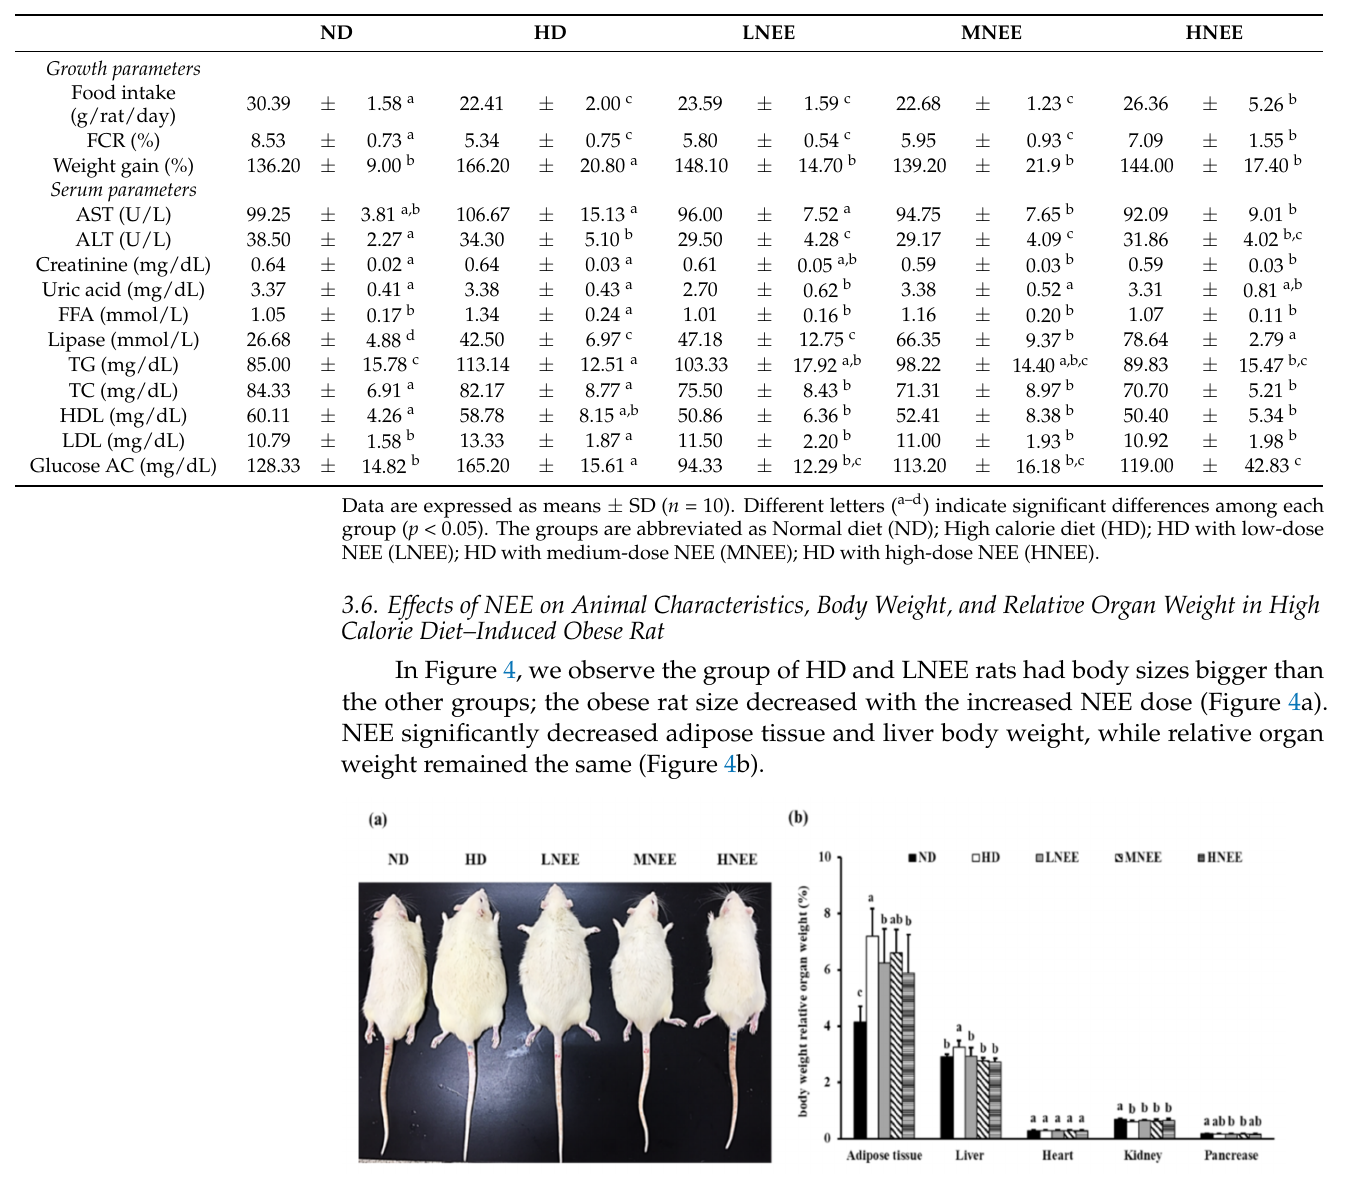
Table 2. Effects of NEE on growth parameters and serum parameters in high calorie diet–induced obese rats.